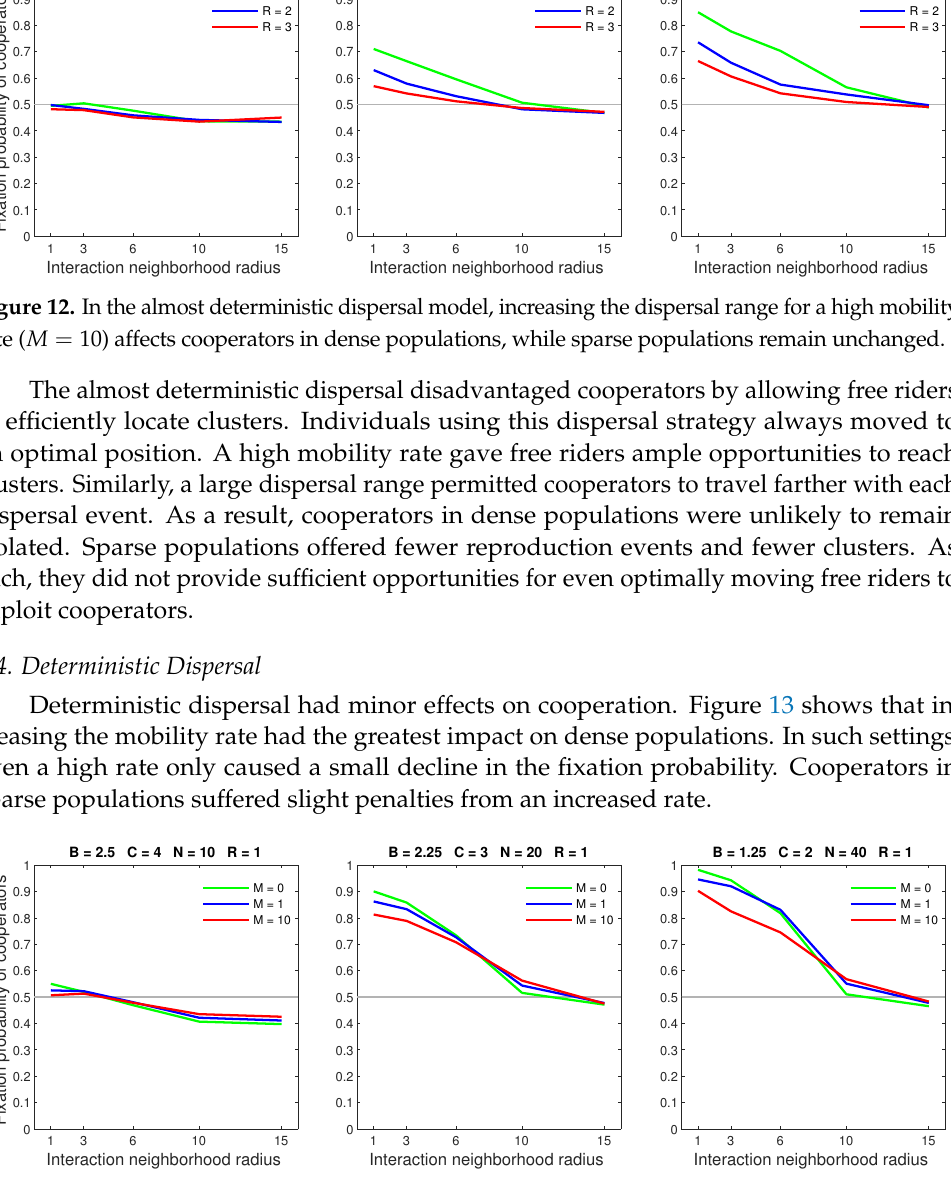
Figure 13. In the deterministic dispersal model, increasing the mobility rate primarily lowers the fixation probability of dense populations with small